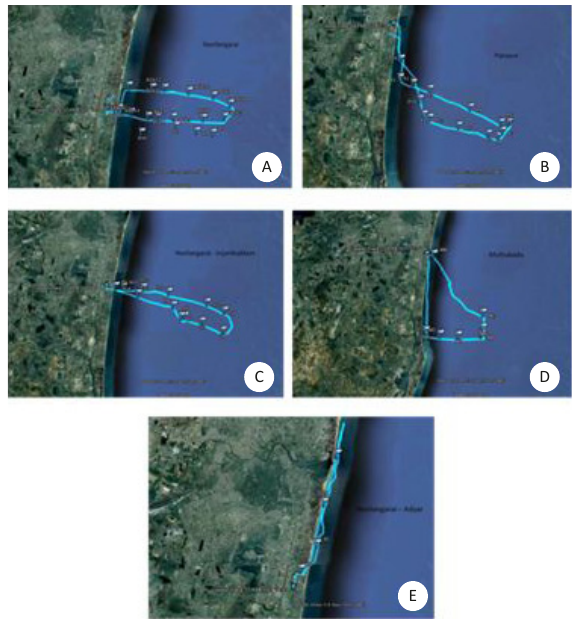
Table 1. Sighting records of Indo-Pacific Humpback Dolphins along Chennai coast